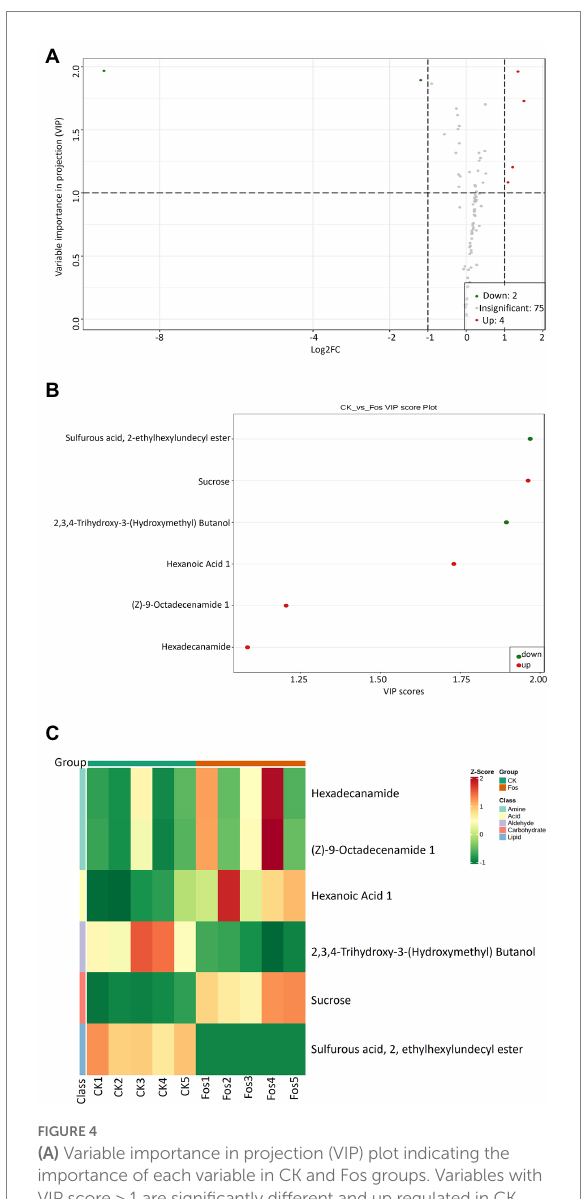
FIGURE 4 (A) Variable importance in projection (VIP) plot indicating the importance of each variable in CK and Fos groups. Variables with VIP score > 1 are significantly different and up regulated in CK while variables with VIP score < 1 are down-regulated in Fos. (B) VIP plot showing the differential expression of significantly important metabolites in both groups (Ck vs. Fos). Each dot is representing a specific metabolite; the red dot is showing the significantly up regulated metabolites while the green dot showing the significantly down-regulated metabolites. (C) Heatmap showing the differential microbial metabolites of Cucumis melo var. saccharinus rhizosphere samples, control group samples (CK1, CK2, CK3, CK4, and CK5) and treatment group samples (Fos1, Fos2, Fos3, Fos4, and